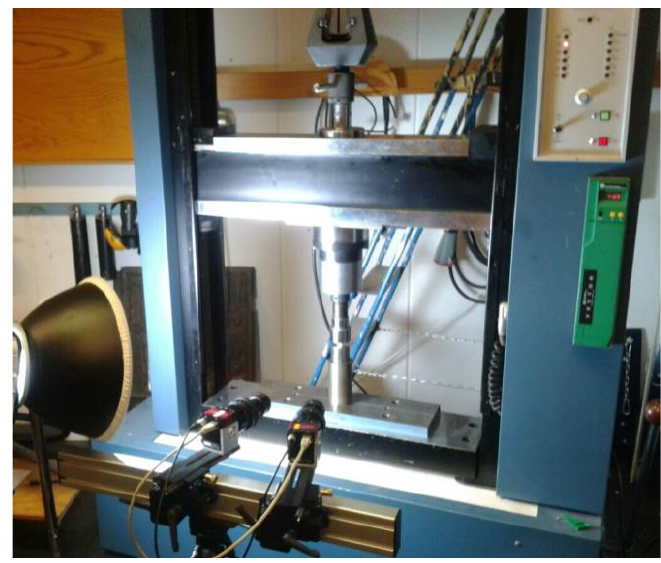
Figure 2. Compression machine at the Solid Mechanics Laboratory.